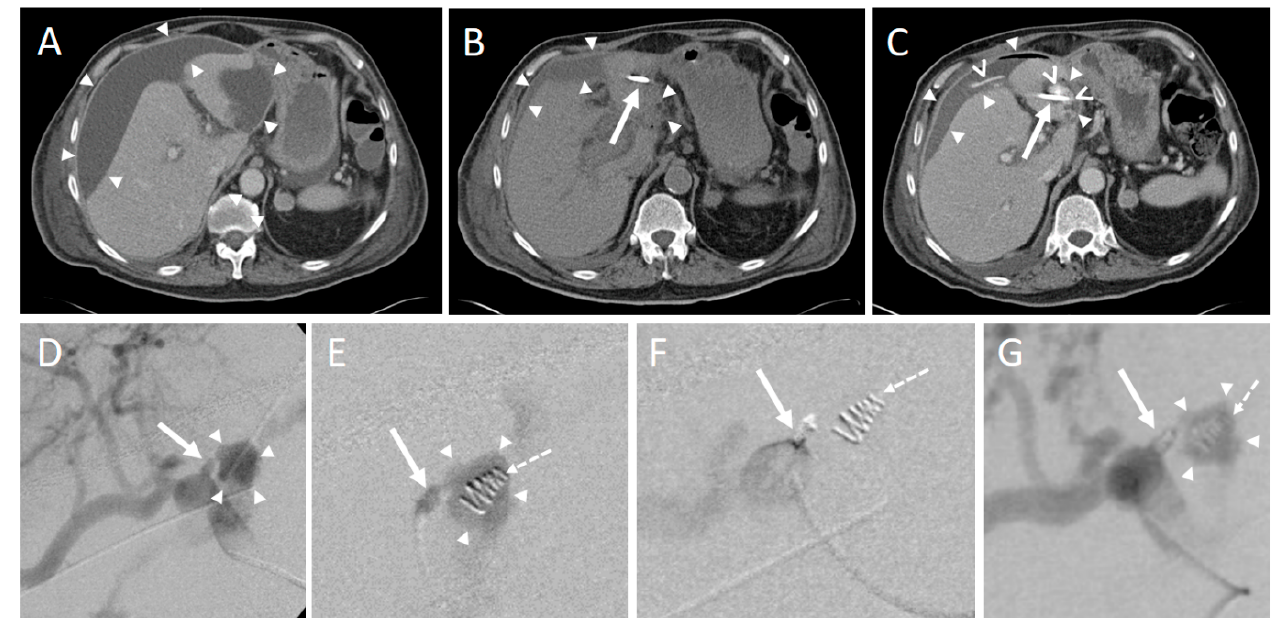
Figure 4. CT-guided drainage placement with a subsequent major complication according to SIR. ( A ) 71-year-old male underwent pancreaticoduodenectomy (PD) due to ductal pancreatic adenocarcinoma. Sixteen days later abdominal revision surgery with hematoma evacuation was performed due to arterial hemorrhage from the hepatic artery and small bowel segment resection due to adhesion ileus. Twenty-seven days after PD a perihepatic subcapsular fluid collection was diagnosed on a CT scan, mainly located at the ventrolateral and medial margins (arrowheads). ( B ) CT fluoroscopy-guided placement of a 10F Flexima ® single lumen drainage (arrow; Boston Scientific, Marlborough, MA, USA) within the fluid collection (arrowheads). After placement, a significant reduction of the fluid was observed. ( C ) Contrast-enhanced CT control scan after eleven days revealed an increase of the subcapsular fluid collections mainly next to the right liver lobe (arrowheads). Contrast medium extravasation occurred inferior to the left liver lobe (segment 3) from the left gastric artery in terms of active bleeding from this vessel. Contrast medium extravasation could also be found in the fluid collection (open arrowheads). Arrow: drainage. An angiographic examination (not shown) performed immediately thereafter did not provide the source of the bleeding. ( D ) Repeated angiography after another 6 days showed extravasation of the contrast agent (arrowheads) from the left hepatic artery (arrow). ( E ) Superselective embolization of the bleeding was performed by placement of an 18/4 (Cook Medical, Bloomington, Indiana, USA) Tornado ® microcoil in the vessel (arrow) supplying the hemorrhage. However, there was an initial misplacement of the coil (dashed arrow), which came to rest in the adjacent pseudoaneurysm (arrowheads). ( F ) Subsequently, placement of a second 18/4 Tornado ® coil was conducted in the vessel neck (arrow; initially misplaced coil: dashed arrow). ( G ) The final angiographic control did not show a remaining contrast agent extravasation. Arrow: Vessel neck with coil; arrowheads: hematoma; dashed arrow: initially misplaced coil. In conjunction with the clinical course, the case was considered to be an arrosion hemorrhage induced by the drainage placement in combination with insufficiency of the biliodigestive anastomosis.